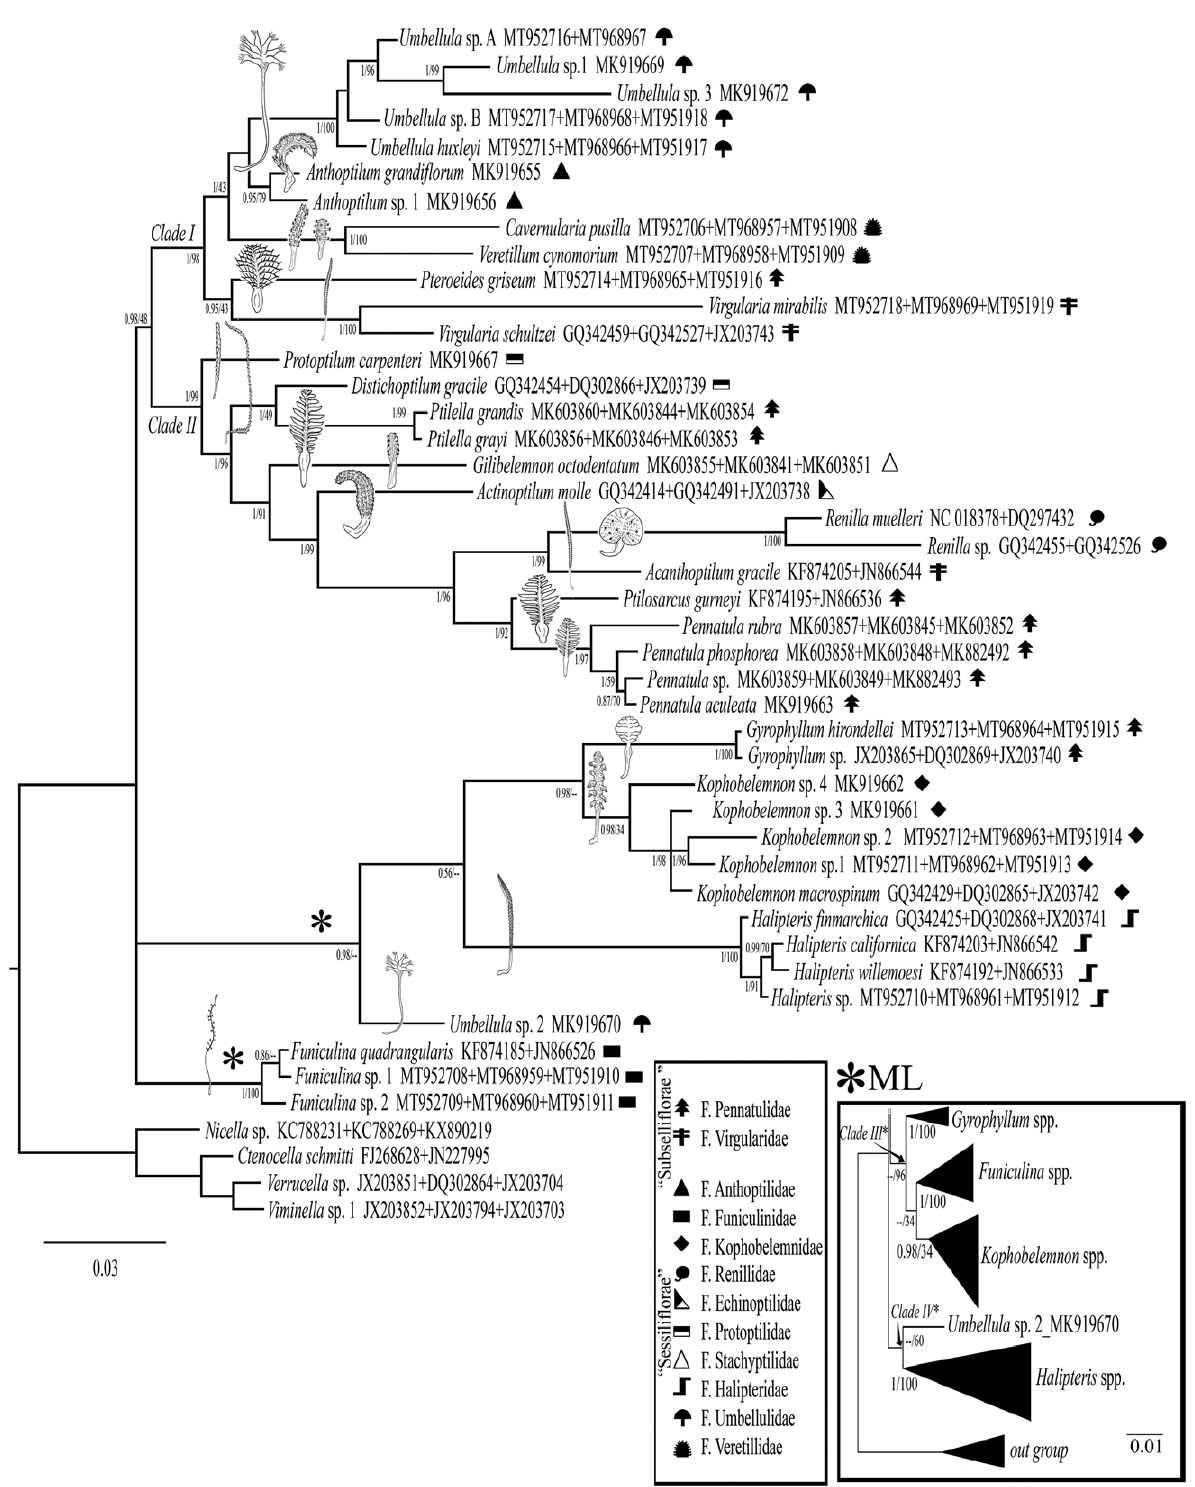
Fig. 1. – Phylogenetic relationships in the order Pennatulacea based on Bayesian inference (BI) for combined regions mtMutS + Cox1 + 28S . A partial phylogeny based on ML is shown in the bottom box (see Results for additional comments), highlighted by asterisk are those groupings that change according to BI method (see Discussion). Posterior probability and bootstrap supporting values are